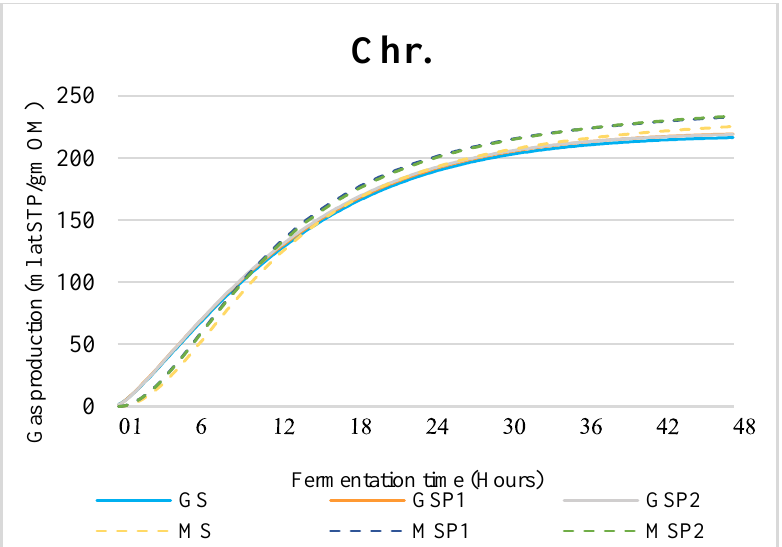
Figure 1. Cumulative gas production of fitted curves from data from fermenting grass silage (GS) and maize silage (MS) with or without probiotic 1 (P1) or probiotic 2 (P2) in rumen fluid for 48 h at two laboratories. Chr.: Chr. Hansen, KU: University of Copenhagen, STP: Standard temperature and pressure, OM: Organic matter. Table 2. Laboratory results for pH, organic matter degradation (dOM), total gas production (TGP), CH 4 yield, and CH 4 concentration after 48 h of in-vitro fermentation of grass silage (GS) and maize silage (MS) with or without probiotic 1 (P1) or probiotic 2